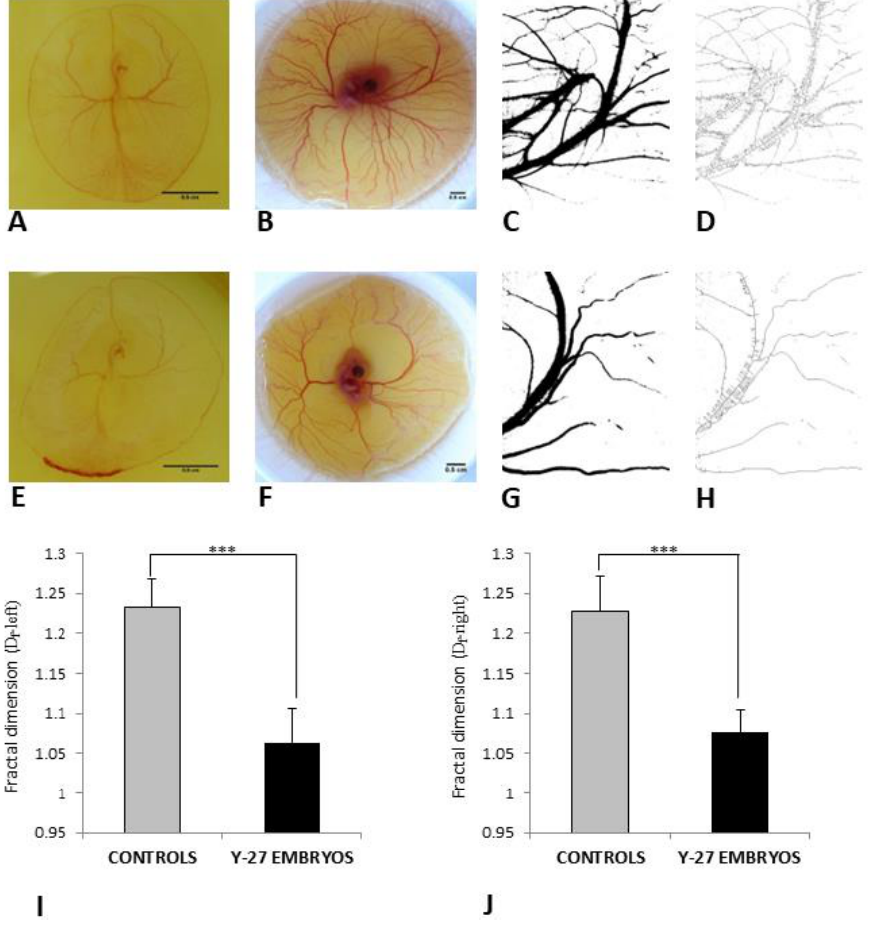
Figure 6. Fractal analysis of control embryo ( A – D ) and Y-27632 (500 µM)-treated embryo ( E – H ) with D f -left ( I ) and D f -right ( J ) at 60 h + 4 d. Prior to treatment, embryos in both groups showed blood islands in the tail region and well-developed extra-embryonic vasculature ( A , E ). Control embryos developed a more complex branching pattern ( B – D ) in comparison to embryos in the experimental group ( F – H ). D f -left was significantly lower in Y-27632 (500 µM)-treated embryos in comparison to controls ( I , *** p < 0.001). There was also a significant difference in D f -right between controls and embryos in the experimental group ( J , *** p < 0.001). The color image version ( B , F ). The segmented version ( C , G ). The skeletonized version ( D , H ). The vertical bars represent the SD. y-axis : Fractal dimension (D f -left, ( I ); D f -right, ( J )). Scale bars: 0.5 cm.